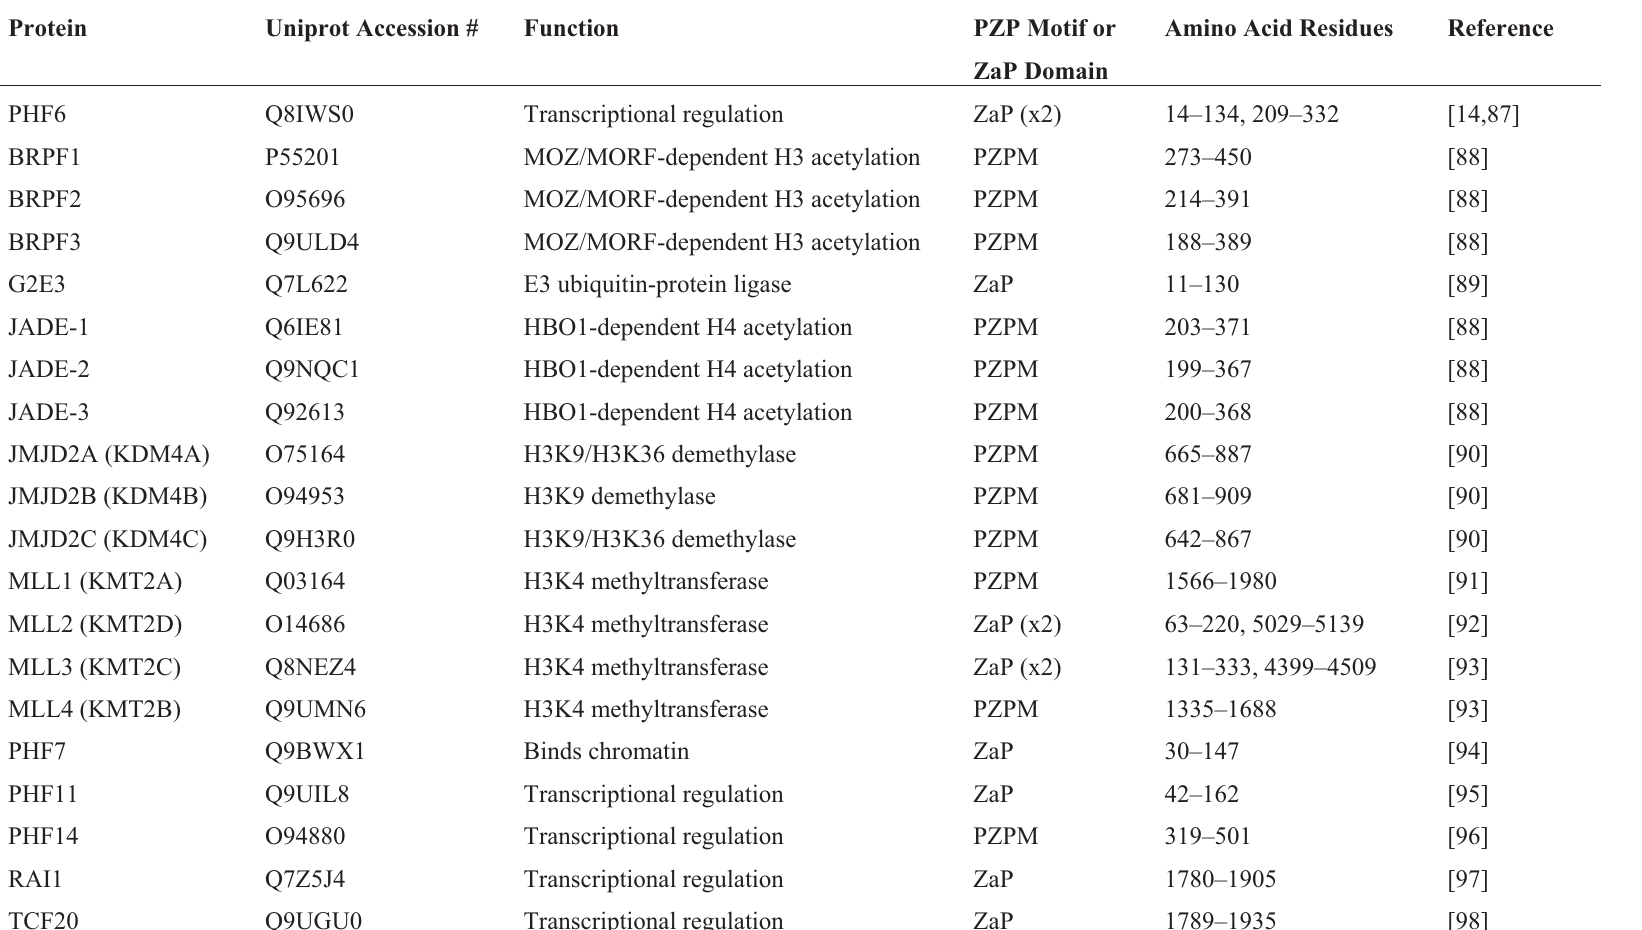
Table 3. Functional comparison of human proteins expressing PZP motifs and/or ZaP